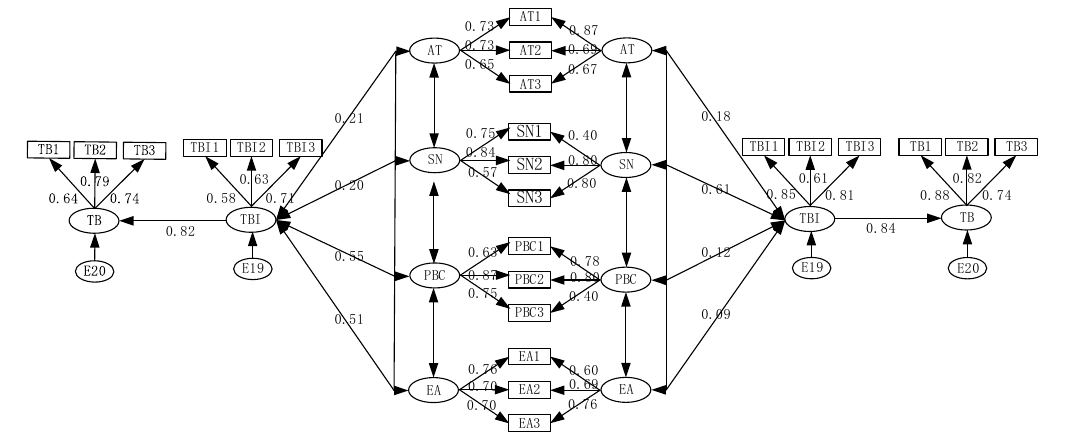
Figure 5. Model results—college students (left)/ office workers (right).